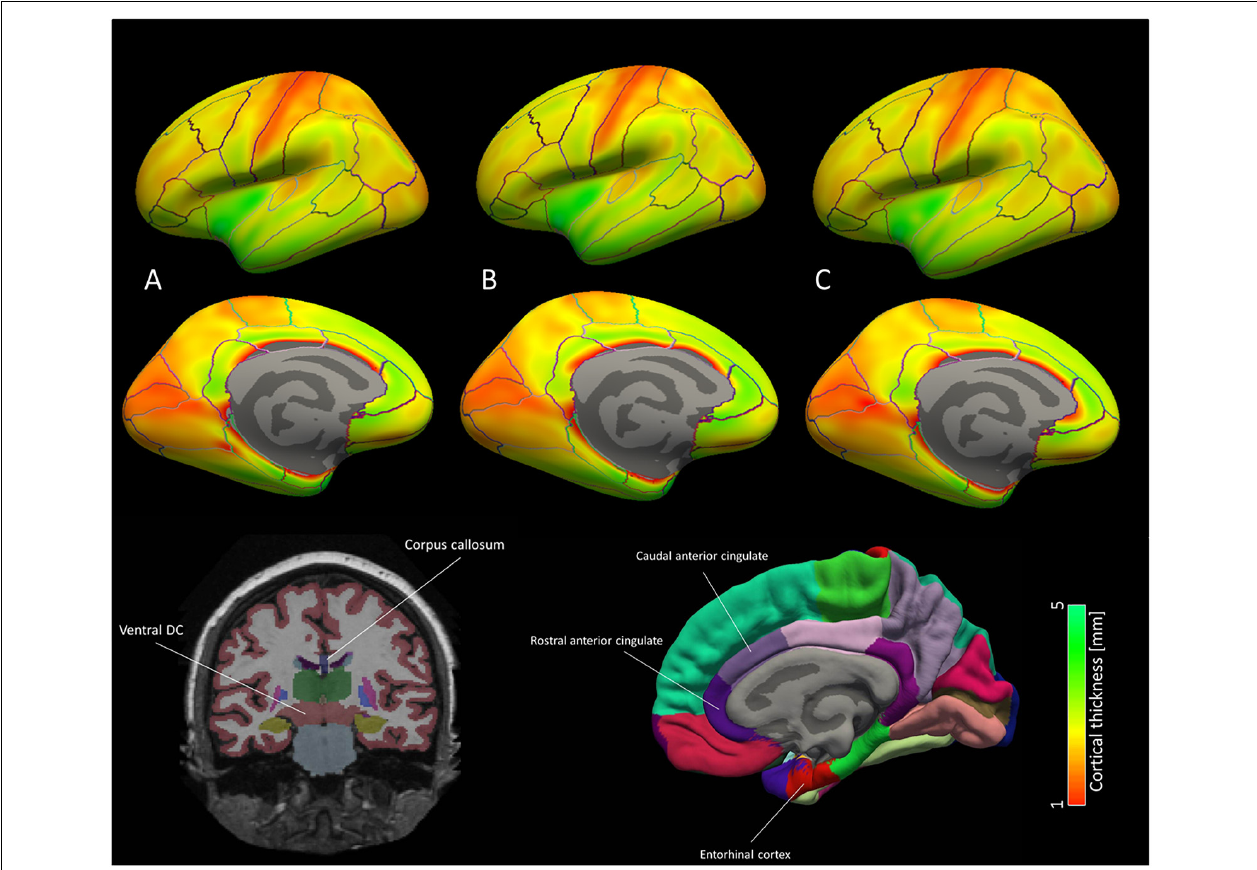
FIGURE 4 | Brain map for the cortical ROI used for the machine learning classification models. Average cortical thickness values for the three groups according to NIAA AD score [ (A) no change, (B) low change and (C) intermediate to high change] are portrayed for each hemisphere. According to machine learning and mixed model results, discriminative patterns for the NIAA AD score may be driven primarily by thickness of the entorhinal cortex and caudal anterior cingulate cortex as well subcortical ROI left ventral diencephalon and anterior corpus callosum, which are depicted schematically below the brain map. In the brain map, only cortical ROI are